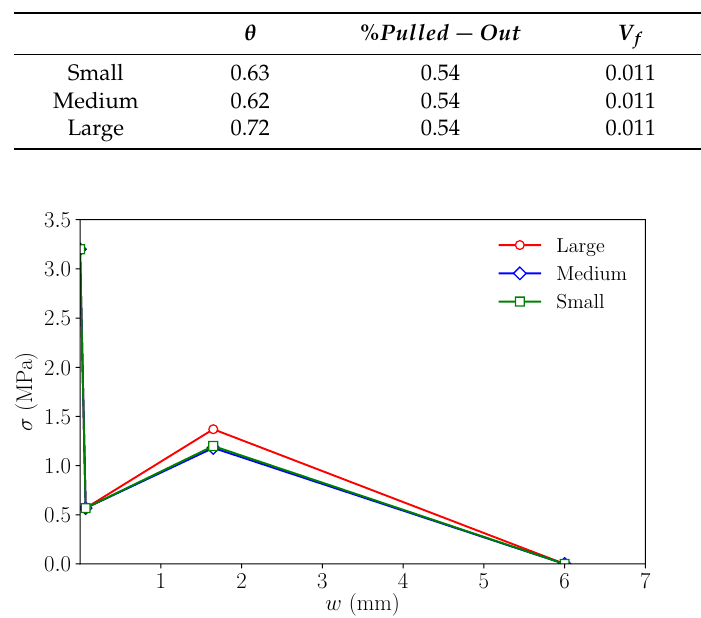
Figure 6. Initial trilinear softening